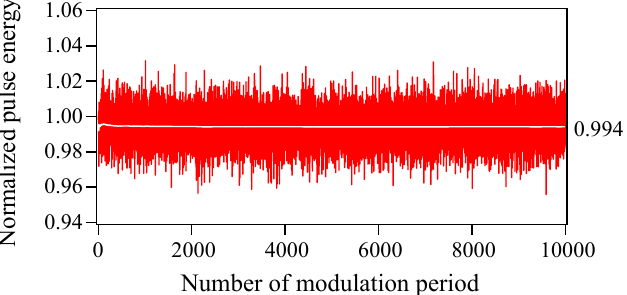
Figure 5. Temporal variation in the pulse energy from 0 to 10,000 times the modulation period with Langevin noise included. The pulse energy is normalized to that in the absence of Langevin noise. The averaged pulse energy is indicated by a white line.